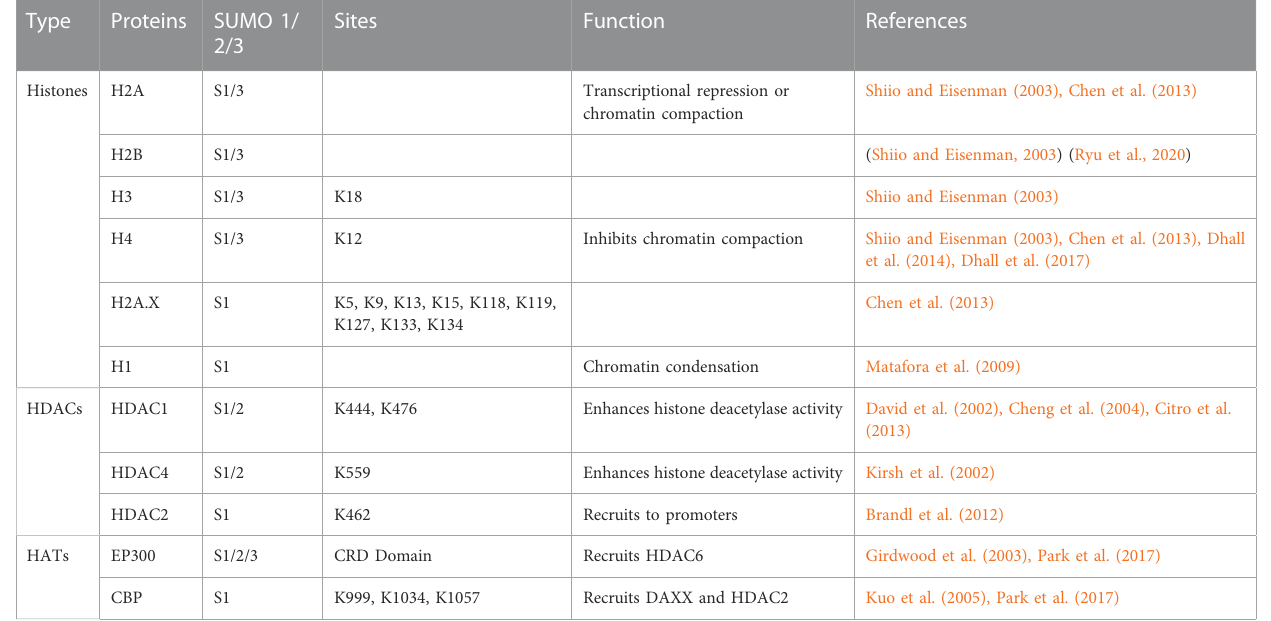
(Table 1). SUMOylation of H4 leads to chromatin compaction and